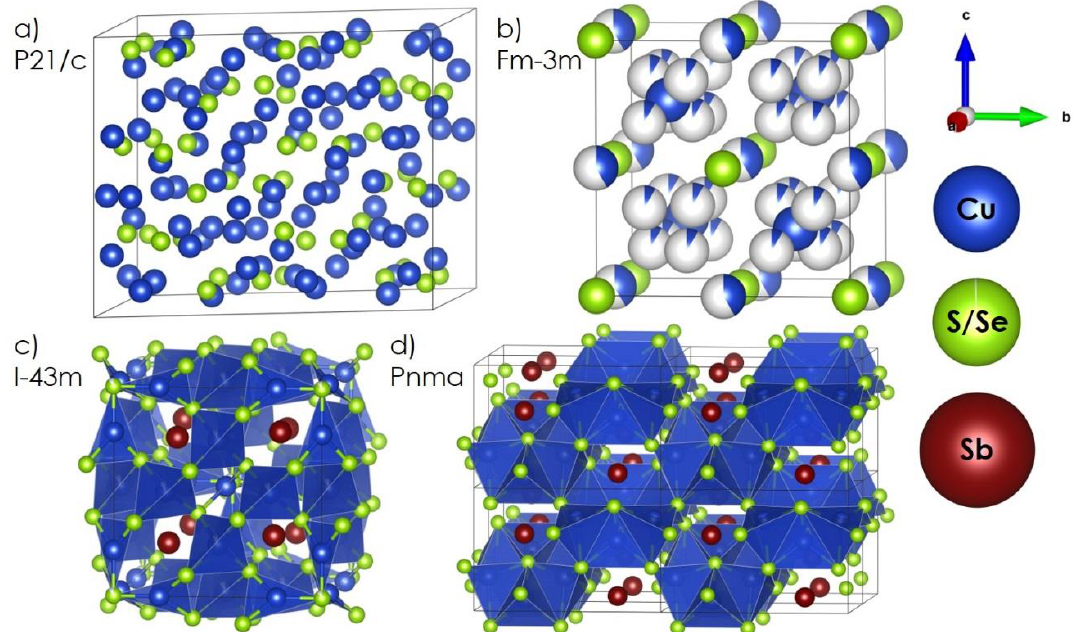
Figure 1. Schematic representation of the considered structures: ( a ) monoclinic, low-temperature Cu 2 − x Ch, ( b ) cubic, high-temperature Cu 2 − x Ch (considering partially occupied sites), ( c ) cubic tetrahedrite, ( d ) orthorhombic Cu 3 SbCh 3